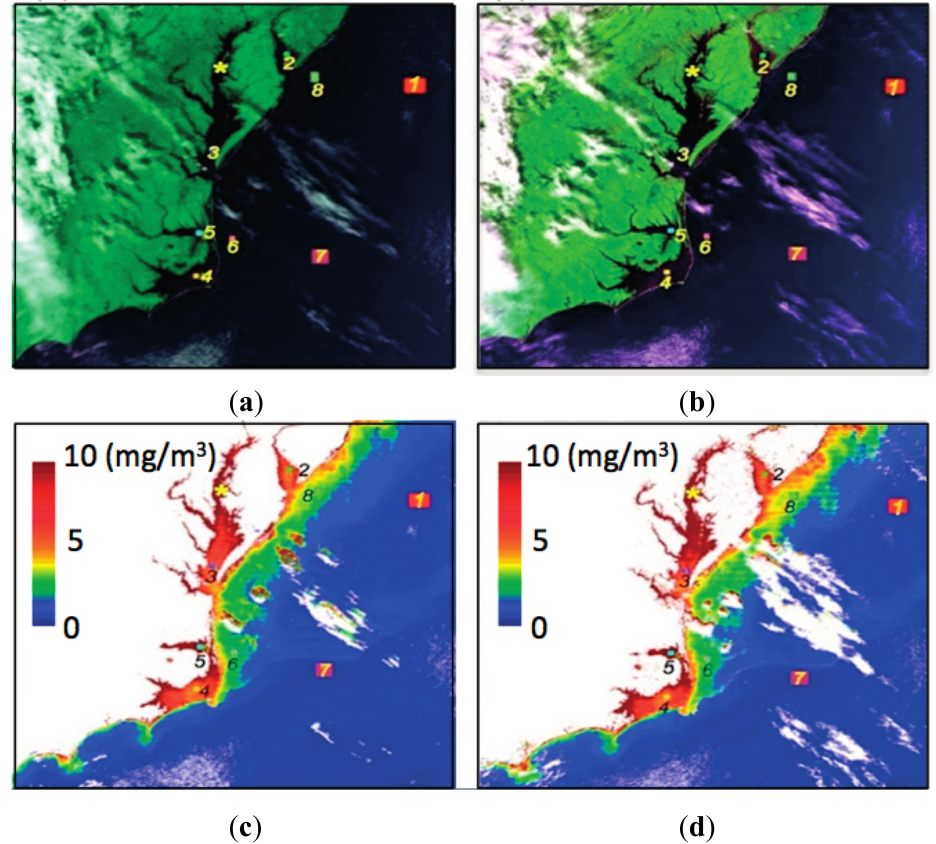
Figure 1. Satellites image over the Chesapeake Bay, acquired on 10 January 2013: ( a ) Aqua-MODIS RGB image; ( b ) VIIRS RGB image; ( c ) MODIS chlorophyll concentration (mg/m 3 ); and ( d ) VIIRS chlorophyll concentration (mg/m 3 ). Eight regions of interest (ROIs) were randomly chosen for inter-sensor comparisons on the seven ocean color channels. The yellow star (*) in the image is the location where the HyperPro in situ measurement is